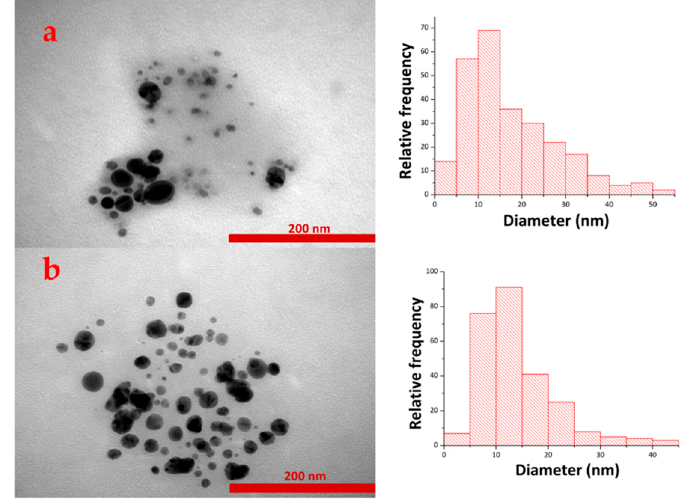
Figure 6. TEM micrographs and size distributions of the AgNPs for the nanocomposite A ( a ) and B ( b ).